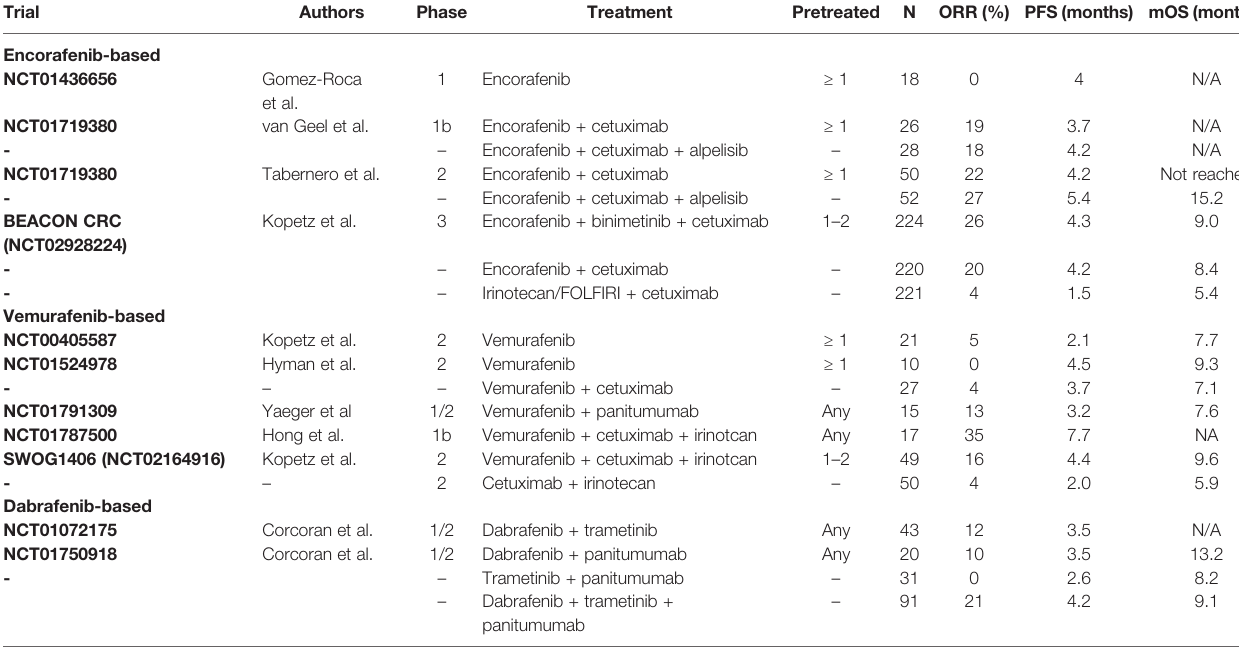
TABLE 2 | Ef fi cacy of targeted therapies for BRAF V600E – mutated mCRC. Trial